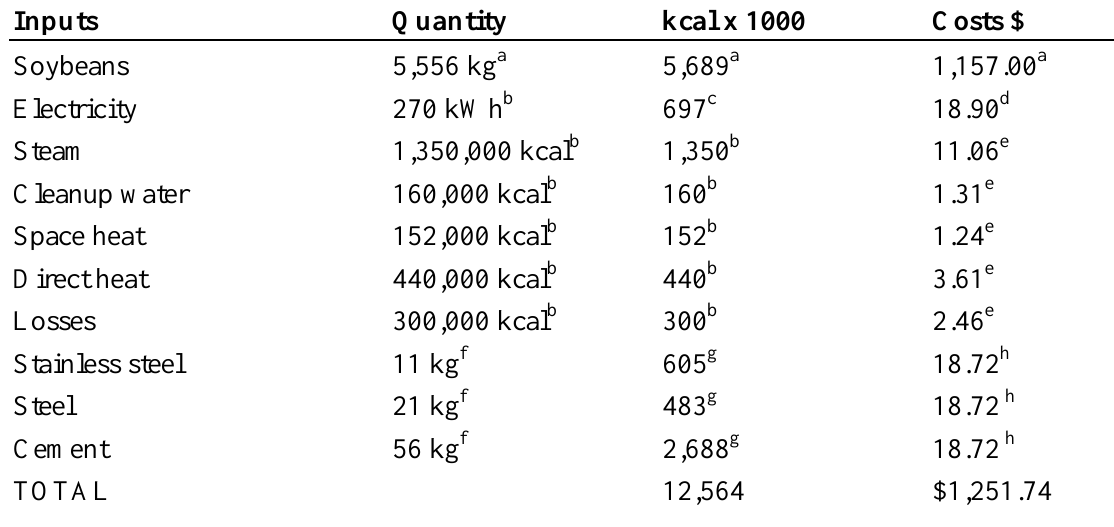
Table 9. Inputs per 1,000 kg of biodiesel oil from